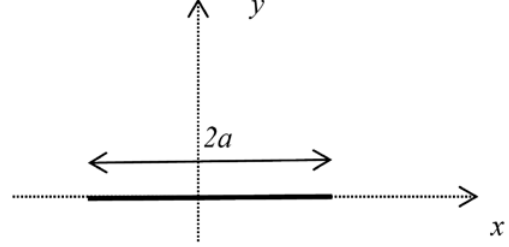
Figure 1: Plane weakened by one